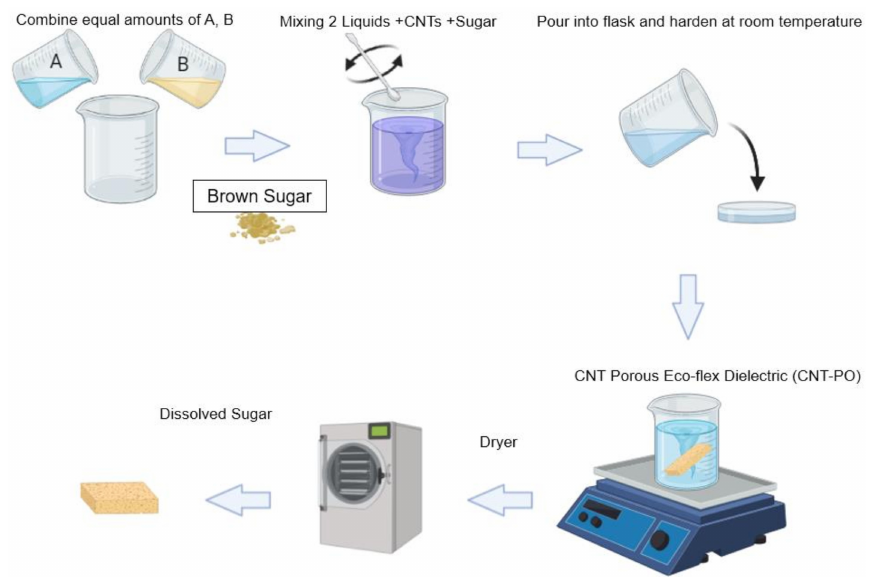
Figure 5. A fabrication process of the Porous Composite Dielectric Layer. Table 2. Dielectric films with different volume ratios of CNTs inside the Ecoflex